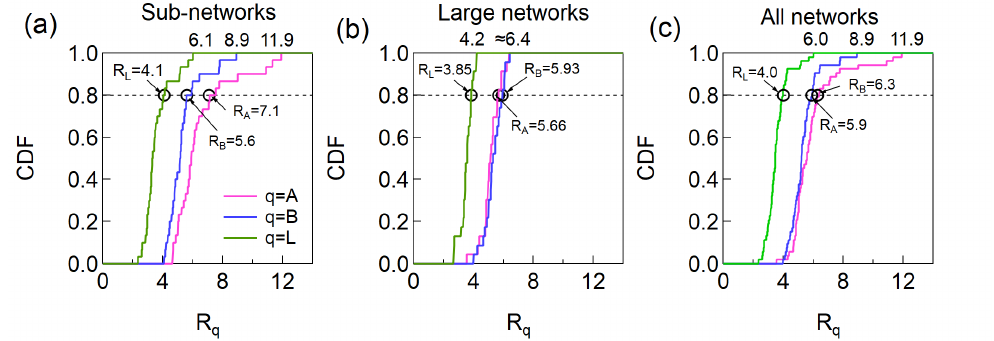
Figure 4. ( a , b ) CDF curves of Horton ratios for large and sub-networks and ( c ) joint distribution. The horizontal dashed-line is the reference value